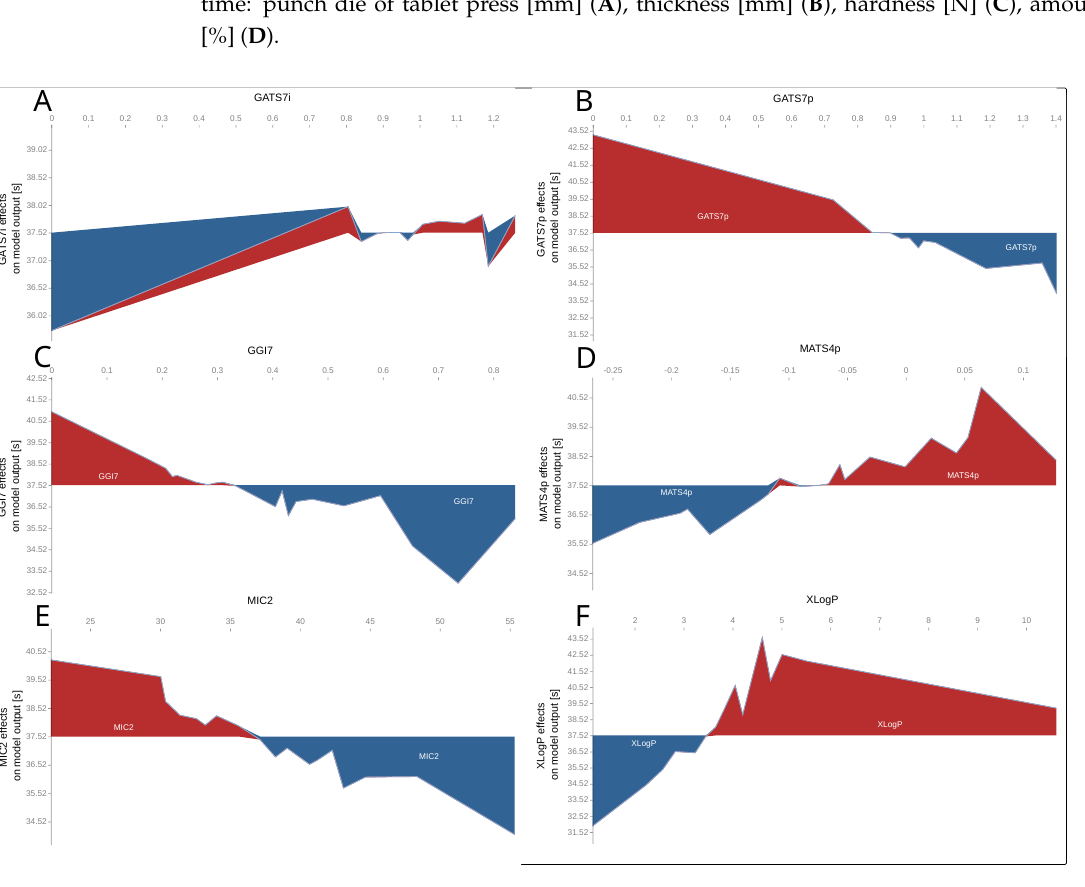
Figure 7. SHAP plots representing the effects of APIs molecular descriptors on disintegration time. GATS7i and GATS7p, the Geary autocorrelation with lag 7 descriptors, weighted by ionization potential ( A ) or polarizability ( B ); GGI7, the topological charge index of order 7 ( C ); MATS4p, the Moran autocorrelation of lag 4 weighted by polarizability ( D ); MIC2, a modified information content index, neighborhood symmetry of 2-order descriptor ( E ); XLogP, a theoretical n-octanol–water partition coefficient ( F